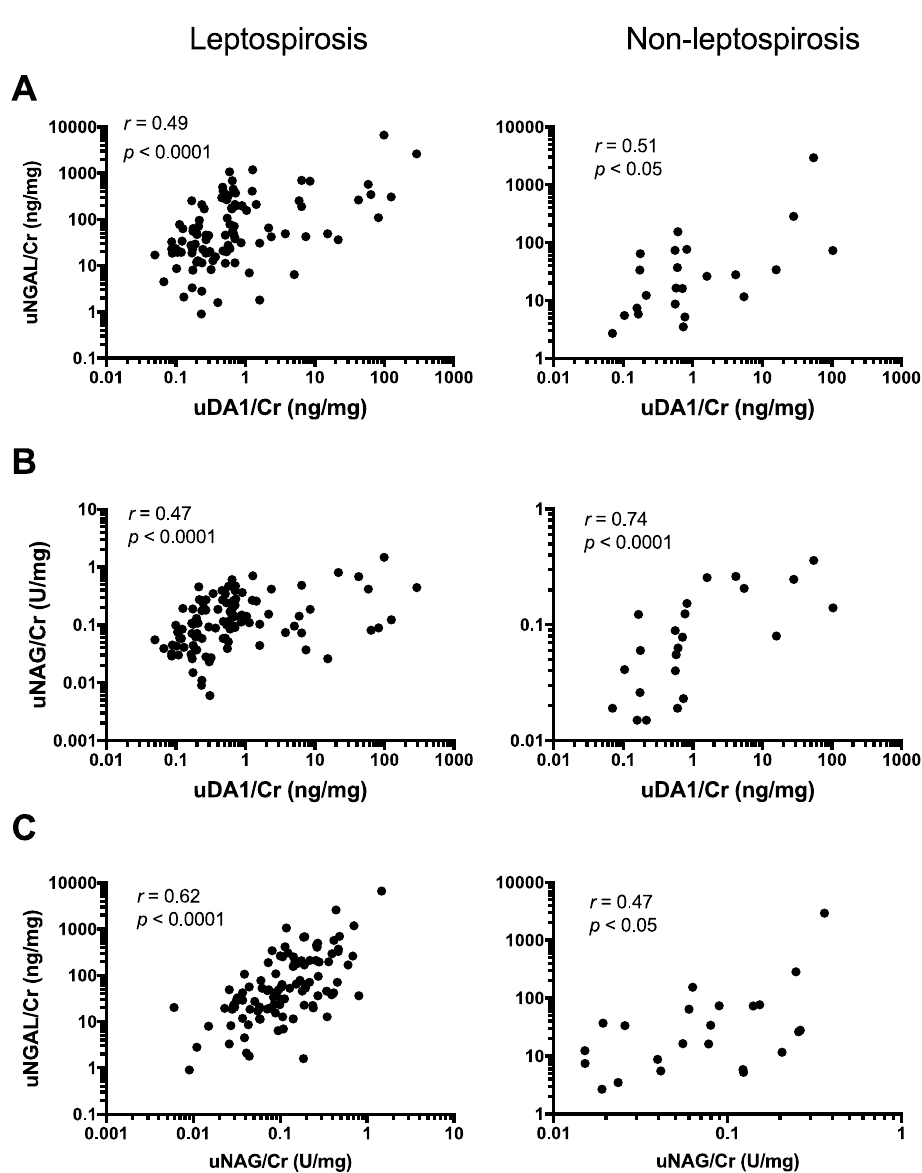
Figure 1. Association between urinary levels of uDA1/Cr and those of uNGAL/Cr ( A ); or uNAG/Cr ( B ); and correlation between uNGAL/Cr and uNAG/Cr levels ( C ) in leptospirosis patients and non-leptospirosis patients.